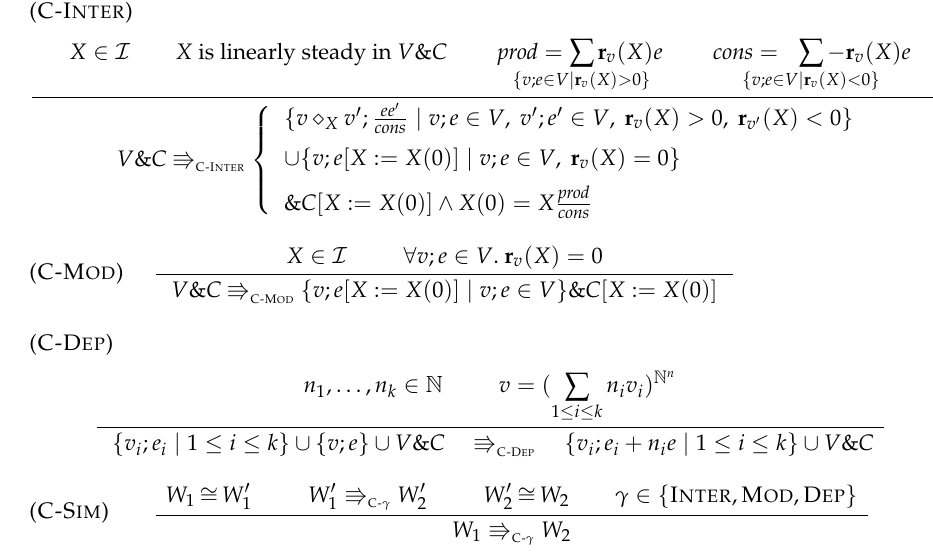
Figure 16. Simplification rules for n-ary constrained flux networks, with I the set of intermediate species and r the n -tuple of initial